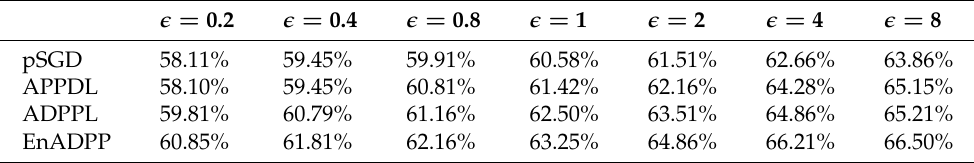
Table 2. The accuracy of EnADPP framework and comparison methods on ADNI